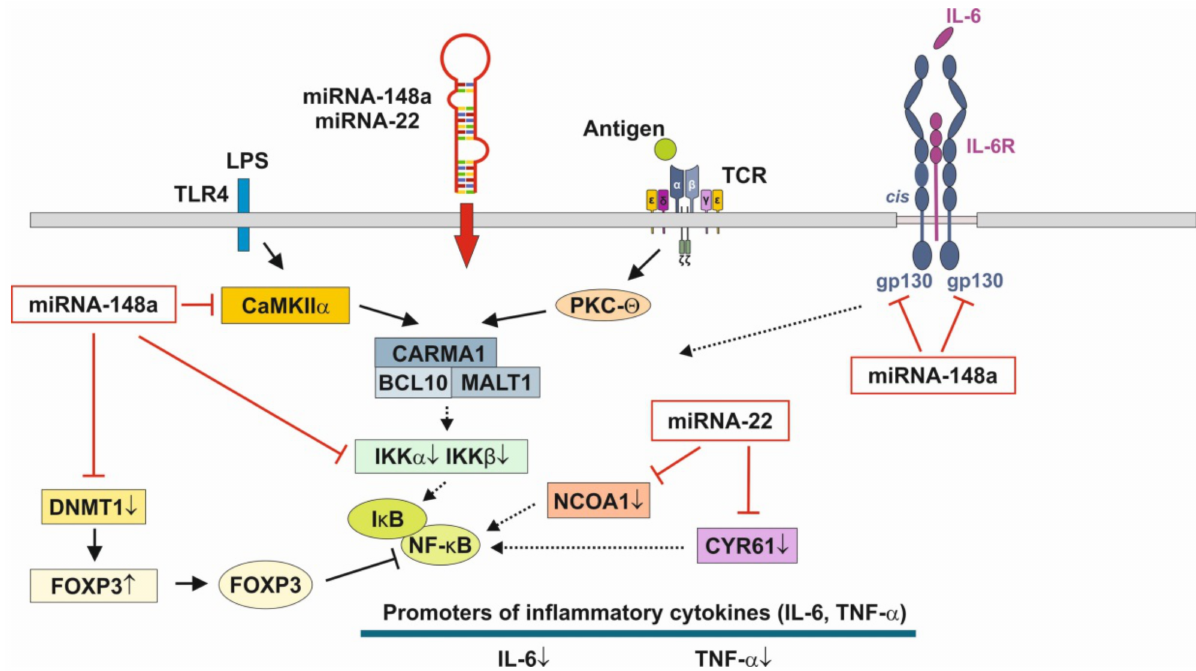
Figure 3. Anti-inflammatory actions of miRNA-148a and miRNA-22 on nuclear factor κ B signaling. miRNA-148a via suppression of DNA methyltransferase 1 (DNMT1) enhances the expression of FOXP3, which is a negative regulator of nuclear factor κ B. miRNA-148a directly targets calcium/calmodulin-dependent protein kinase II α (CaMKII α ), which phosphorylates CARD-containing MAGUK protein 1 (CARMA1) involved in the activation of I κ B kinase α (IKK α ) and I κ B kinase β (IKK β ), Notably, miRNA-148a directly targets IKK α and IKK β , thereby enhancing the inhibitory effect of I κ B on NF- κ B. In addition, miRNA-148a targets the interleukin 6 (IL-6) signal transducer gp130. miRNA-22, which is highly expressed in preterm MEX, targets nuclear receptor co-activator 1 (NCOA1) and cystein-rich protein 61 (CYR61), which both activate NF- κ B. miRNA-30b via targeting RIP140 suppresses IL-6 expression. MEX-derived miRNAs thus provide anti-inflammatory